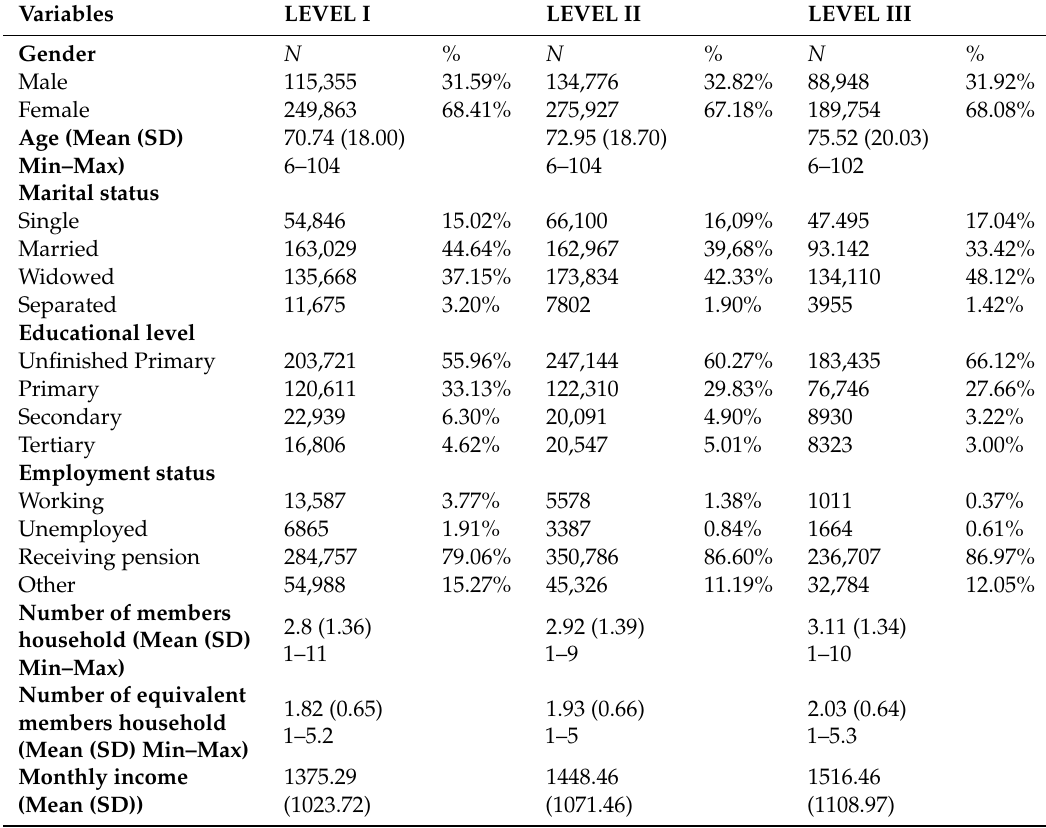
Table 4. Sociodemographic variables by level of dependence EDAD-08.